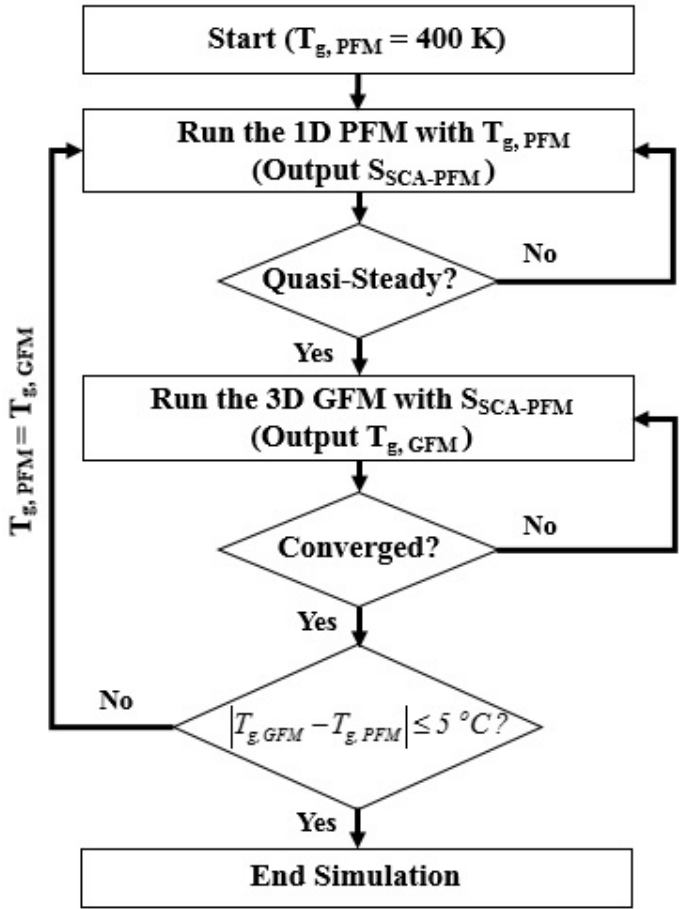
Figure 3. The flowchart of the model coupling.